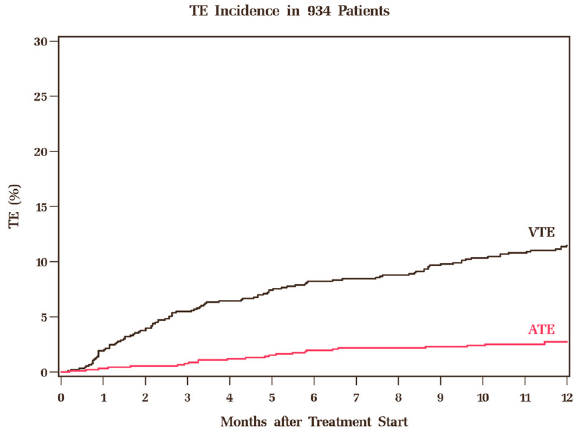
Fig. 1 Incidence of arterial and venous thromboembolism in the fi rst year after treatment initiation. ATE Arterial Thromboembo- lism, VTE Venous